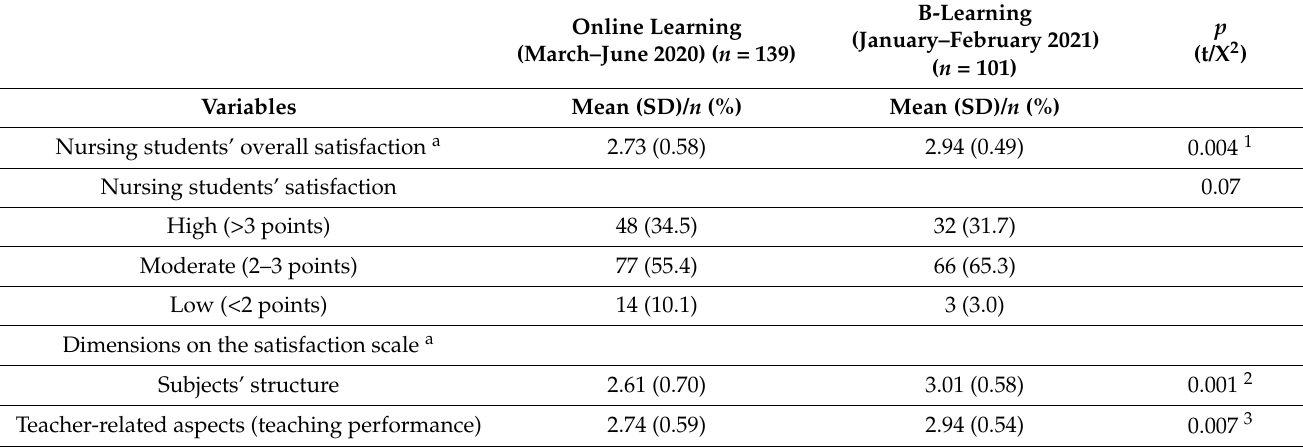
Table 2. Bivariate analysis. Relation between dimensions on the satisfaction scale and nursing students’ satisfaction with the learning